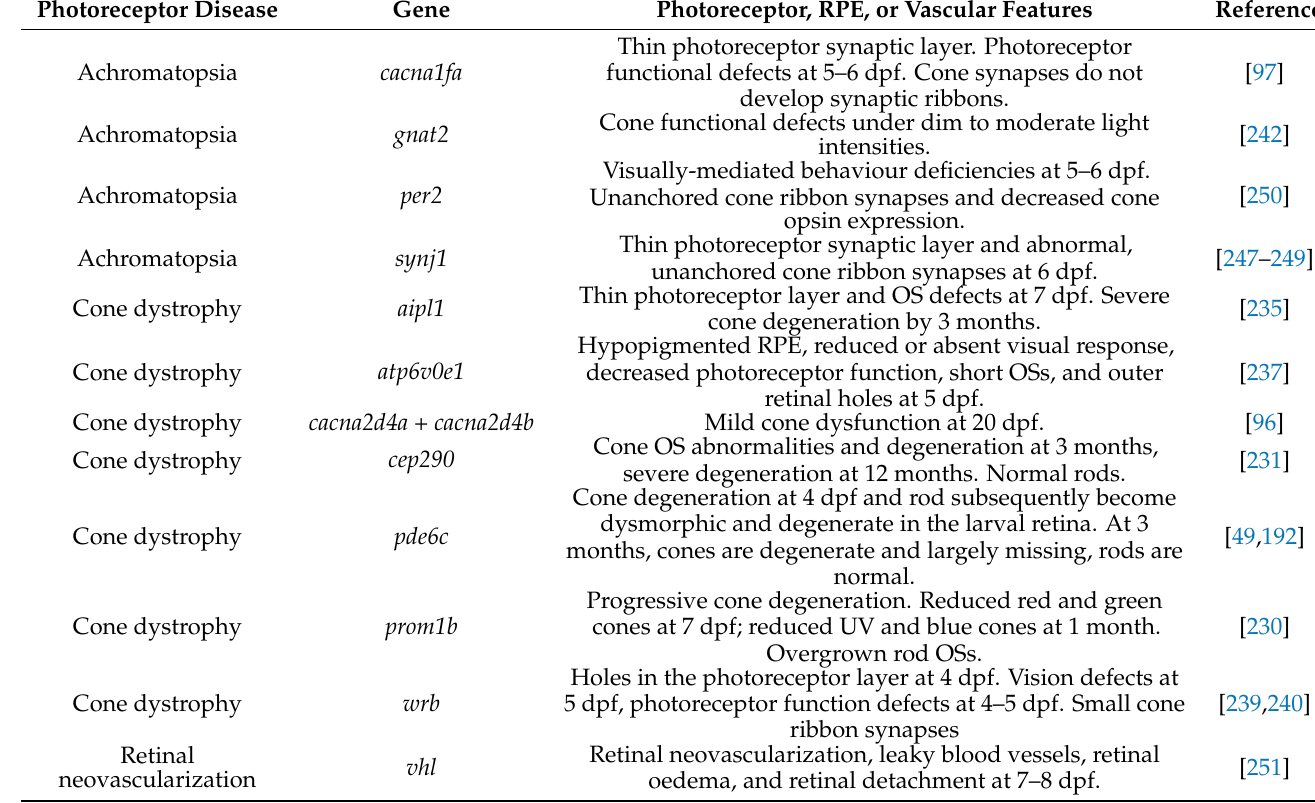
Table 7. Zebrafish mutant models of cone dystrophy, achromatopsia, and retinal neovascularization. Photoreceptor